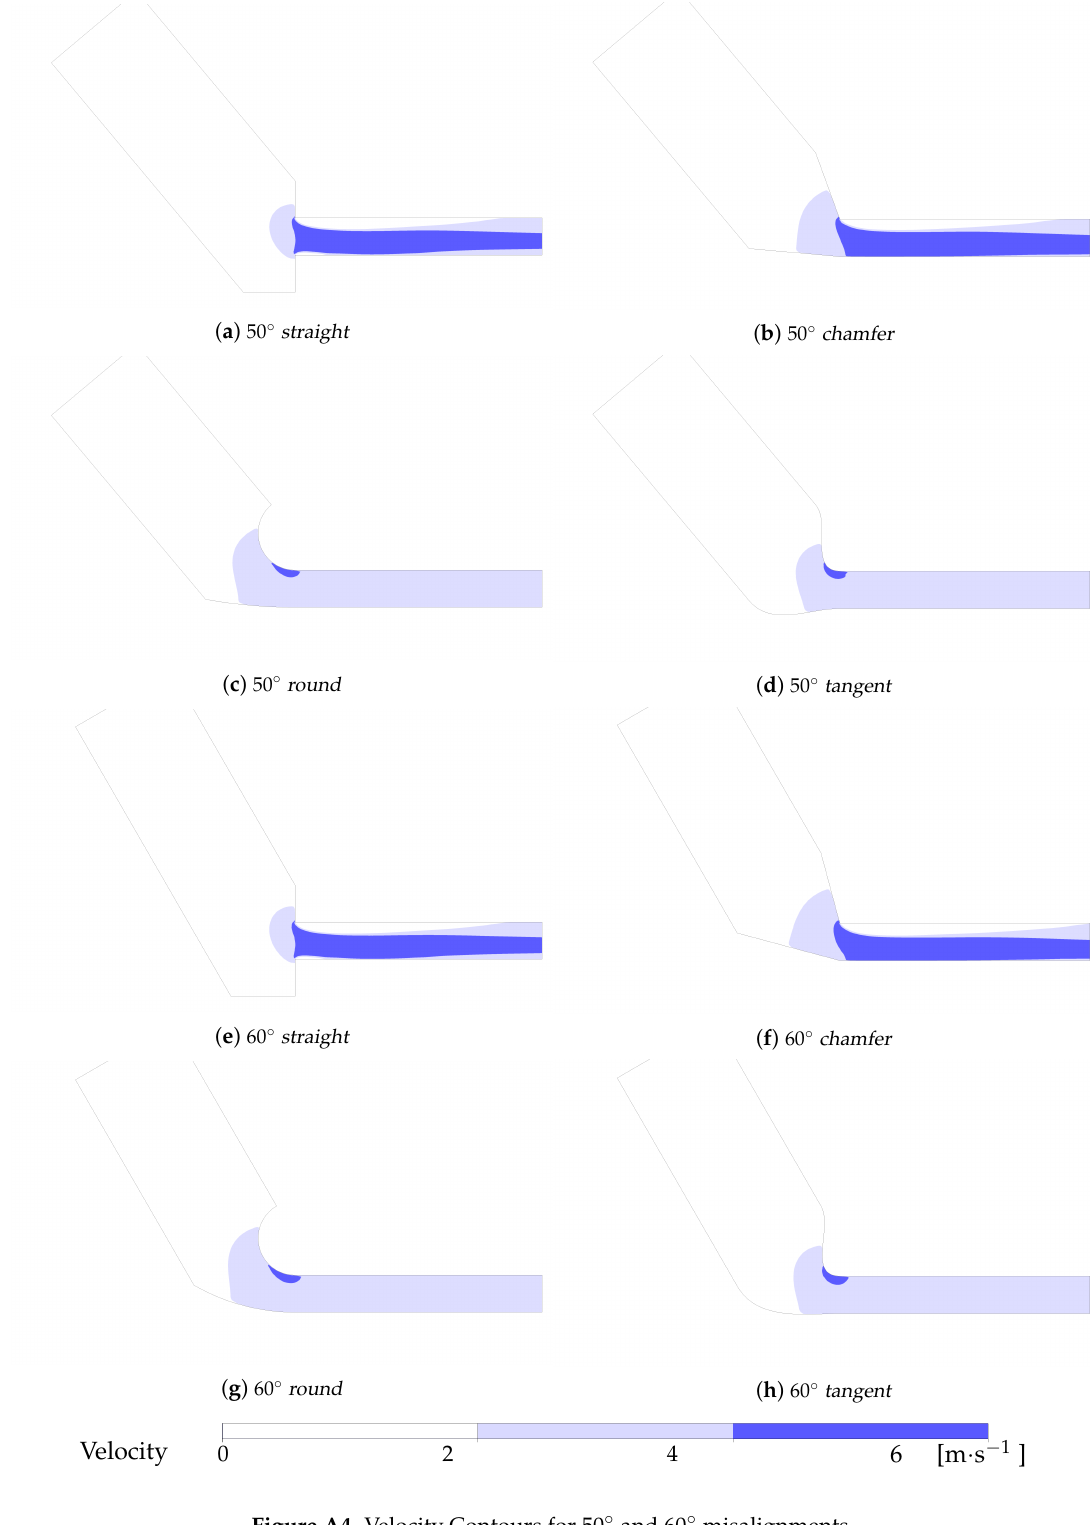
Figure A4. Velocity Contours for 50 ◦ and 60 ◦